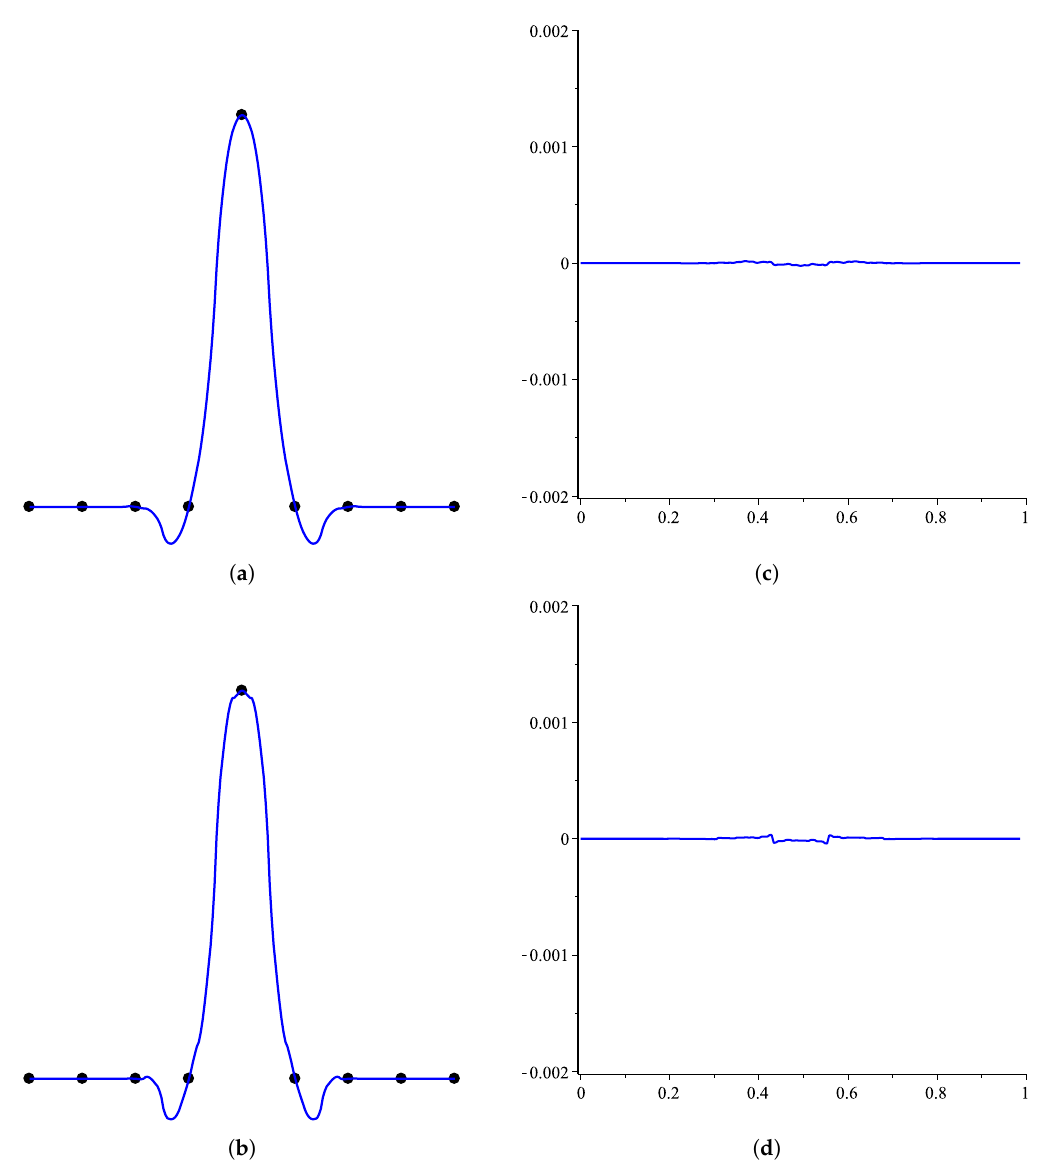
Figure 5. Results for various choices of the parameter u are shown on the left together with their corresponding curvature on the right. From top to bottom: u = 0 and 0.0074. ( a ) Limit curve at u = 0; ( b ) Limit curve at u = 0.0074; ( c ) Curvature plot of ( a ); ( d ) Curvature plot of ( b